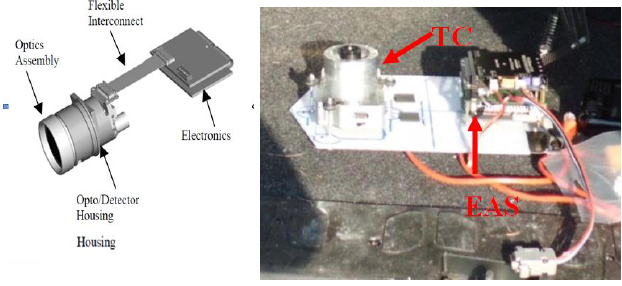
Figure 4. Thermal Camera (TC) 3600 scheme (left); TC and embedded acquisition system (EAS) final configuration